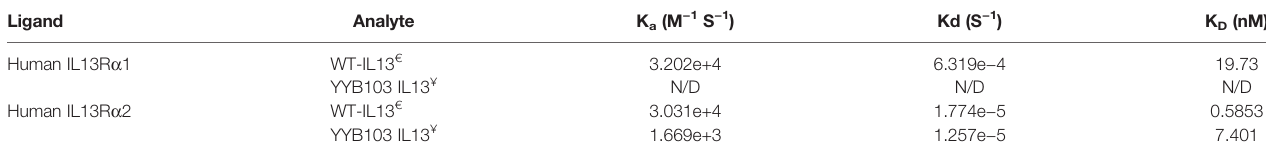
TABLE 1 | Measurement of af fi nity of WT-IL13 and YYB-103 IL13 for human IL13R a 1 and IL13R a 2. Ligand